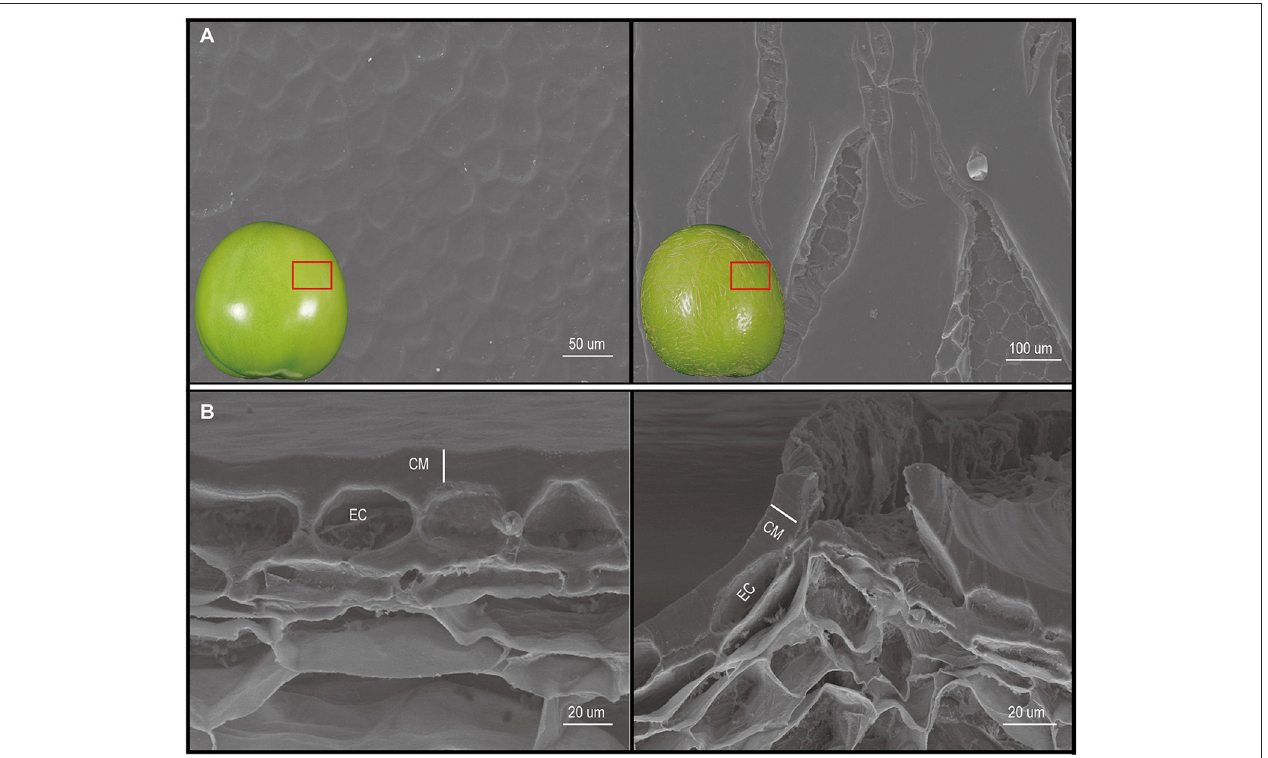
FIGURE 1 | Scanning electron microscopy (SEM) observation of the cuticle of mature wild type (WT) and epidermal reticulation (ER) fruit. (A) Images of the fruit cuticle surface. (B) Images of fruit cuticle cross-sections. Images on the left are from the WT genotype, and those on the right are from the ER fruit. CM, cuticular membrane; EC, epidermal